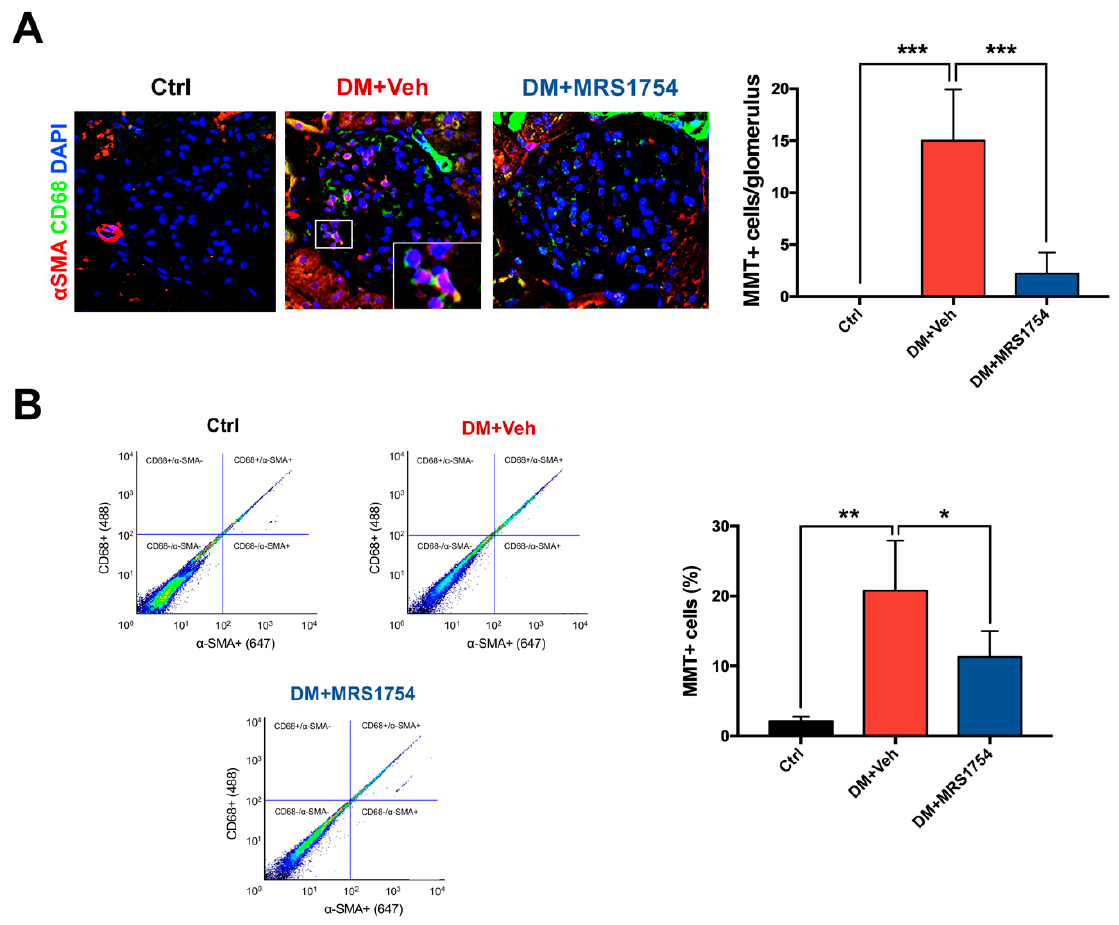
Figure 5. A 2B AR antagonism decreases in vivo intraglomerular macrophage–myofibroblast transition in diabetic nephropathy rats. ( A ) Immunohistofluorescence of CD68 (macrophage marker; green color) and α -SMA (myofibroblast marker; red color) in glomeruli of non-diabetic (black; Ctrl), diabetic (red; DM+Veh), and diabetic MRS1754-treated (blue; DM+MRS1754) rats at twelve week post-STZ inoculation. DAPI (blue) was used as a counterstain. The box at the lower right corner of the middle image represents a magnification of the selected area. Graphs (right panel) represent quantification of MMT+ (CD68+/ α -SMA+) cells per glomerulus. ( B ) Flow cytometry for CD68 and α -SMA in collagenase-digested glomeruli of non-diabetic (black; Ctrl), diabetic (red; DM+Veh), and diabetic MRS1754-treated (blue; DM+MRS1754) rats at twelve weeks post-STZ inoculation. Flow cytometry dot plots (left panel) and graph (right panel) represent the percentage of MMT+ cells in rat glomeruli. Dot plots show the cell abundance in different colors, being green/yellow-red and blue/sky-blue colors high and low number of cells, respectively. Graphs represent the mean ± S.D. * p < 0.05, ** p < 0.01, *** p < 0.005 between groups. n = 4. Selected glomerulus area with a 400x magnification.